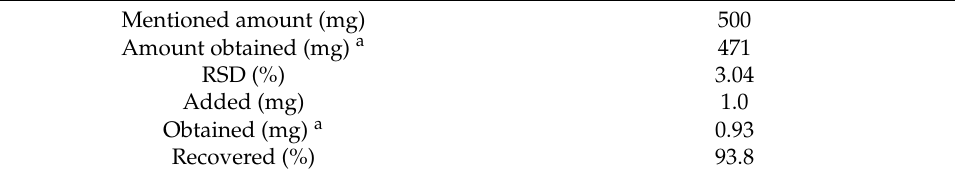
Table 3. Detection of CIP in tablet formulations.